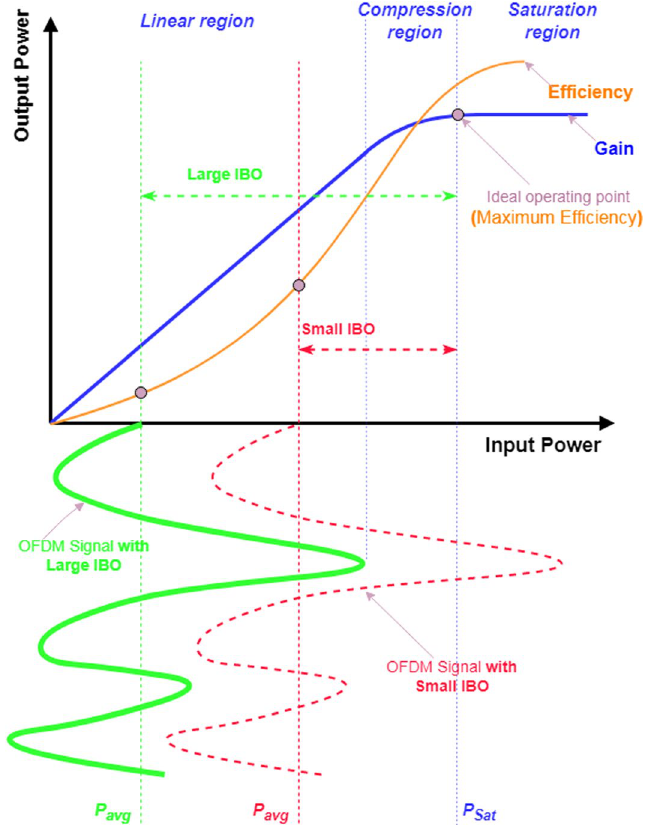
Fig. 2 Effect of IBO on the integrity of the transmitted signal and the efficiency of the HPA